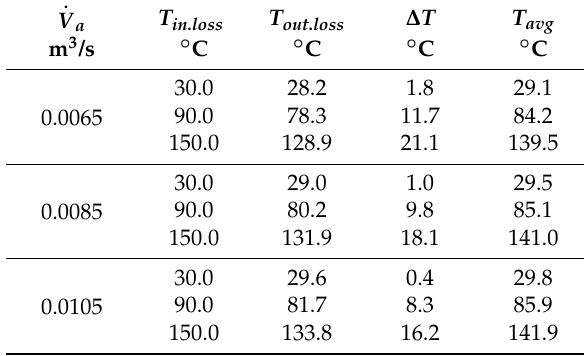
Table 3. The values used to determine heat losses from the dryer.